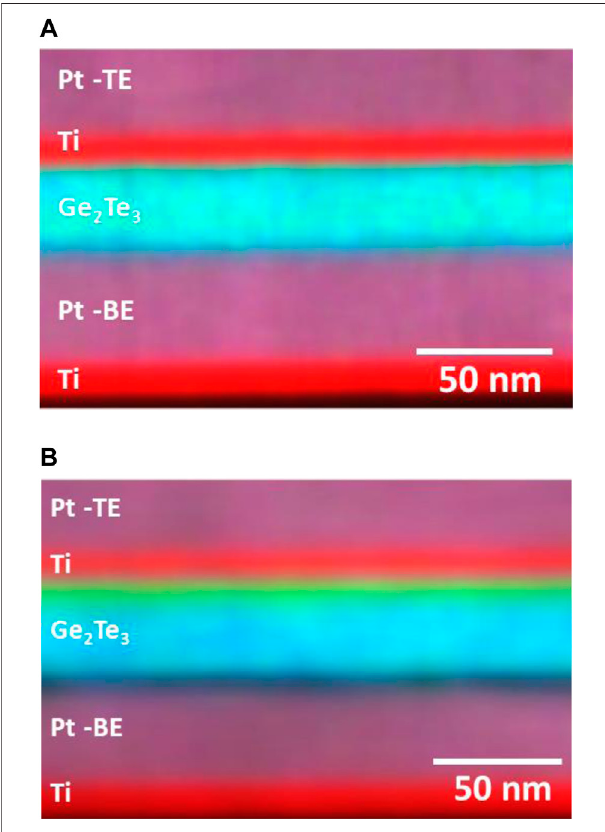
FIGURE 7 | XEDS maps of the device structure (A) in the as-grown condition at room temperature and (B) after heating to 200 °